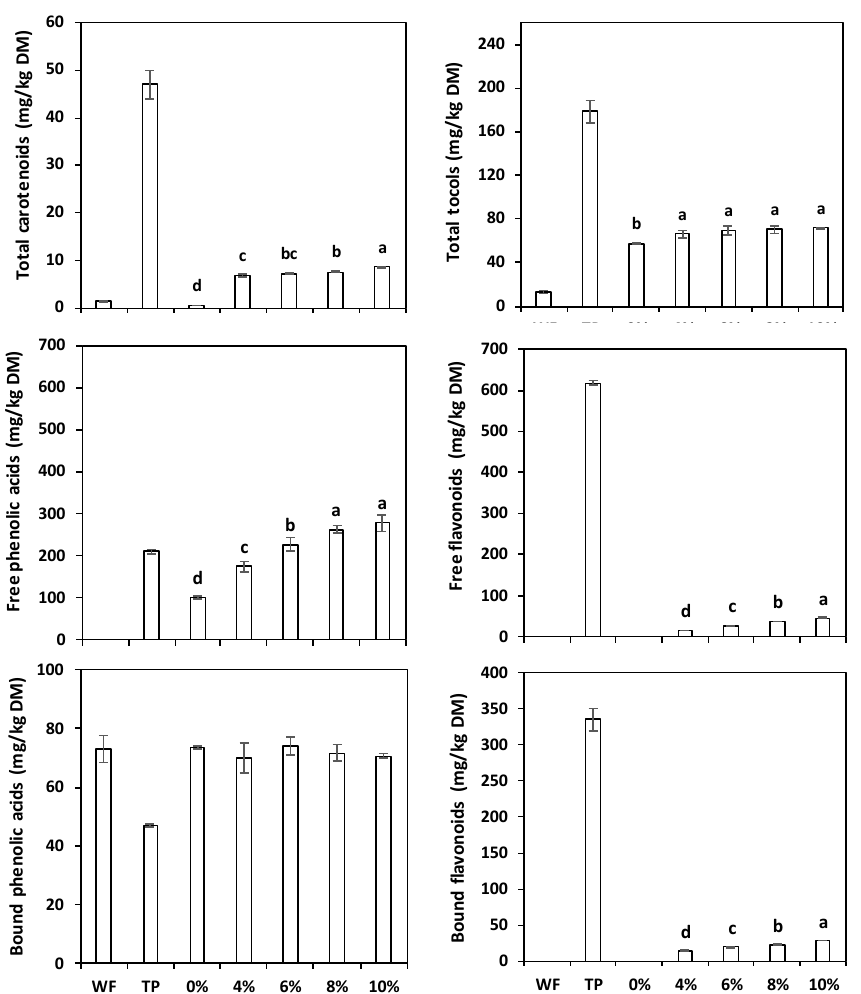
Figure 3. Total carotenoids, total tocols, soluble free phenolic acids and flavonoids, insoluble bound phenolic acids and flavonoid contents of bread wheat flour (WF), tomato pomace (TP), and crackers prepared with increasing TP percentages. The error bars represent the standard deviation; different letters indicate significant differences ( p < 0.05) among cream crackers.